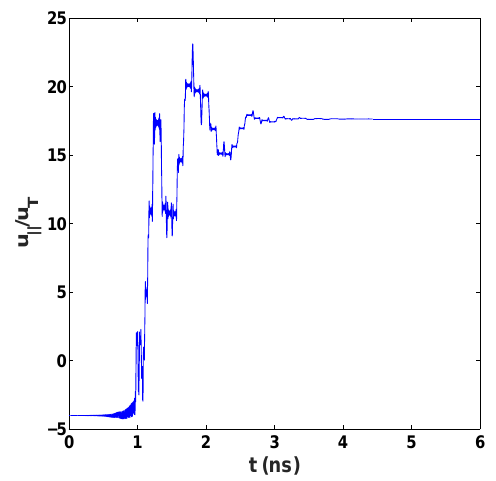
Figure 6. Same as Fig. 2 except that the beam polar- ization is of the extraordinary EC wave.